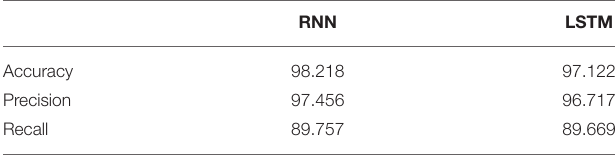
TABLE 8 | Predictive performance evaluation